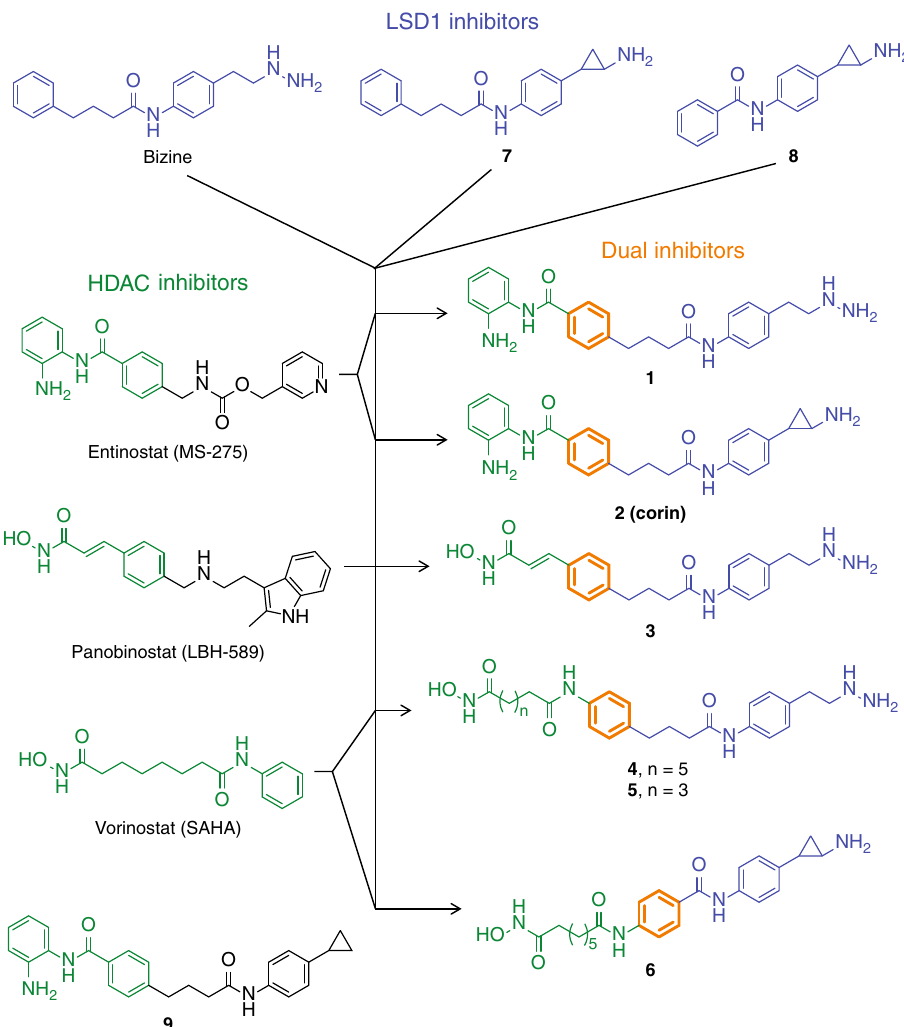
Fig. 1 Strategy for combining the pharmacophores of clinically used HDAC inhibitors and a preclinical LSD1 inhibitor to generate dual action HDAC-LSD1 inhibitors. Blue — incorporated LSD1 inhibitor features, Green — incorporated HDAC inhibitor features, Orange — shared structural features, Black — features not incorporated into dual